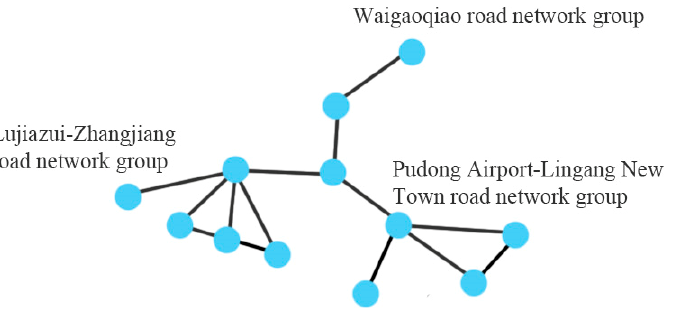
Figure 11. The abstract diagram of “centralized decentralized combination” road network structure in the study area (Source: self-drawn by the author).